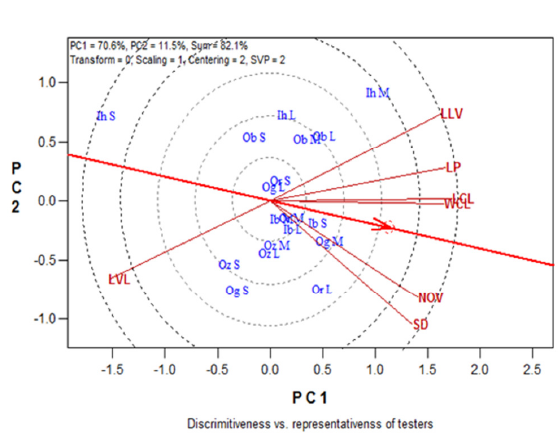
Fig. 2. The discrimination and representativeness view of the GGE biplot to show the discriminating ability and representativeness the test yield traits. NOV=Number of vine, LLV=Length of the Longest Vine (cm), LP= Number of Leaves per Plant, LVL= Number of leaves per vine length of 40 cm, WCL=Width of the Central Leaflet (cm), SD=VD=Vine Diameter (mm), LCL= Length of the Central Leaflet (cm) and YIELD= Leaf yield. Ob-L, Ob-M, Ob-S, Ih-L, Ih-M, Ih-S, Or-L, Or-M, Or-S, Ib-L, Ib-M, Ib-S, Og-L, Og-M, Og-S, Oz-L, Oz-M, and Oz-S = fluted pumpkin